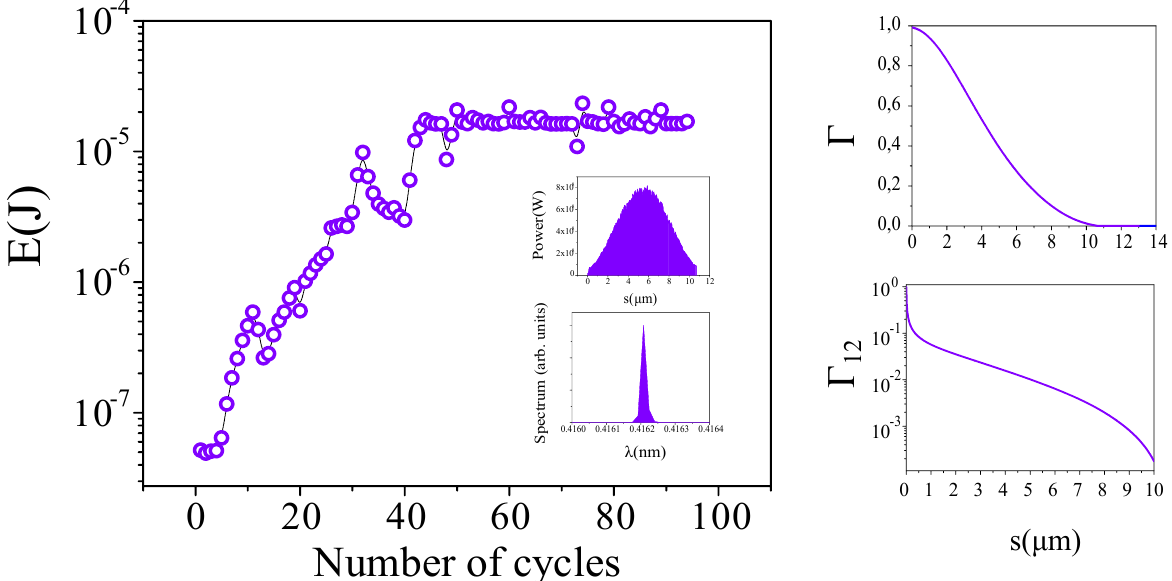
Figure 5. FEL Oscillator. Left window : intracavity energy growth as a function of the number of round trips. Inner boxes: temporal and spectral distributions at saturation. Right windows: auto ( Γ ) and mutual ( Γ 1,2 ) coherence degrees vs. s = c τ . Jitters occur due to the different microscopic structures of the successive electron bunches. In the inner boxes, the temporal and spectral distributions at saturation